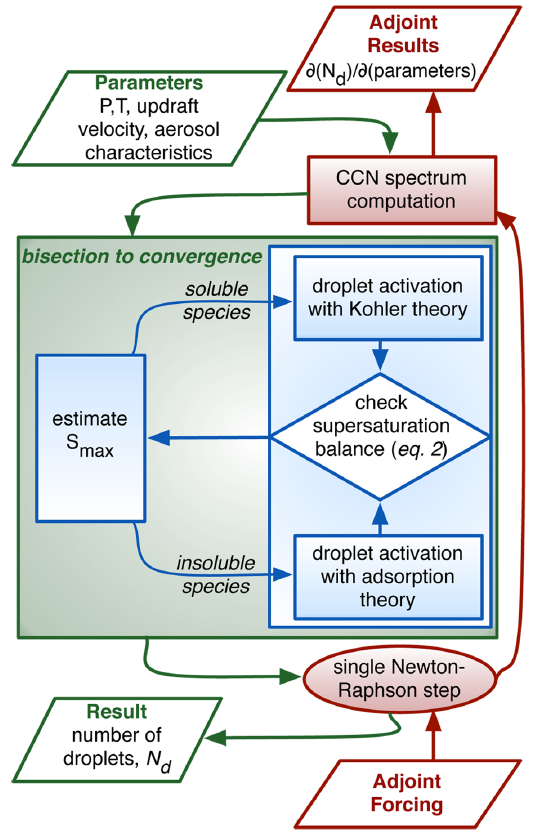
Fig. 1. Flow diagram of the Kumar et al. (2009) parameterization al- gorithm and its adjoint. The adjoint calculation steps are illustrated in